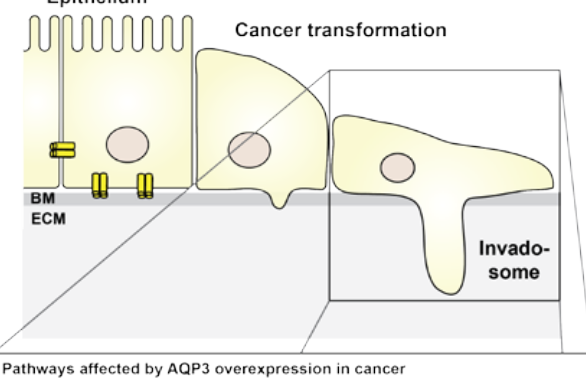
AQP3 correlated with down-regulation of E-cadherin expression and up-regulation of vimentin and fibronectin expression [84]. In addition, T-cell factor (TCF) and lymphocyte enhancer factor (LEF), transcription factors known to be involved in EMT (for review [106,107]), were also affected by AQP3. AQP3 knockdown decreased both TCF and LEF expression levels in SGC7901 and MGC803 gastric cancer cells [98]. Thus, the mechanisms underlying regulation of EMT by AQP3 overexpression is an important future research topic to unravel the role of AQP3 in cancer.